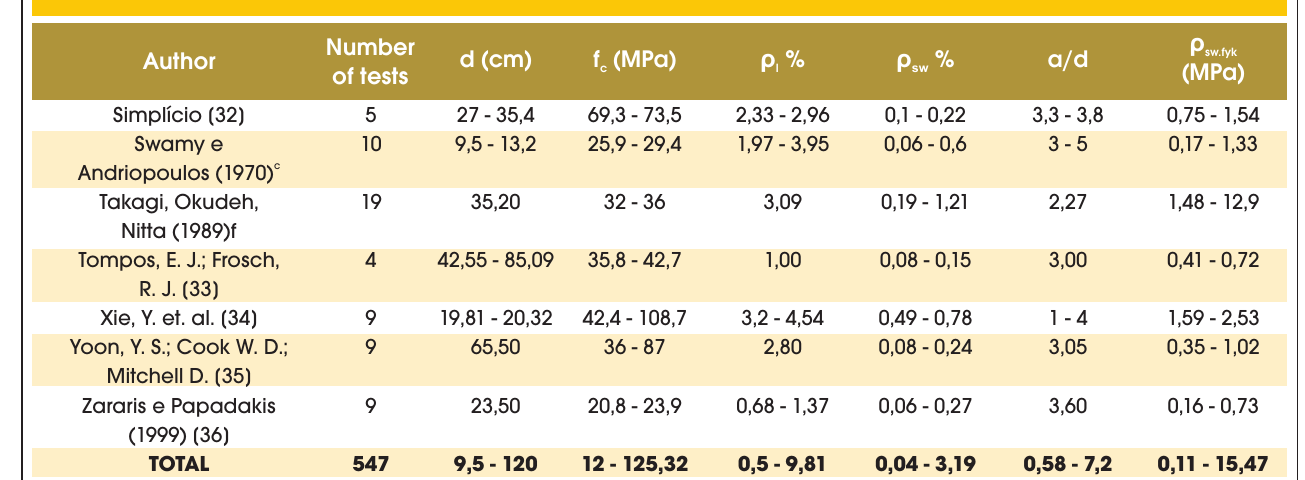
Table 2 – Database for RC beams with stirrups (part 3)